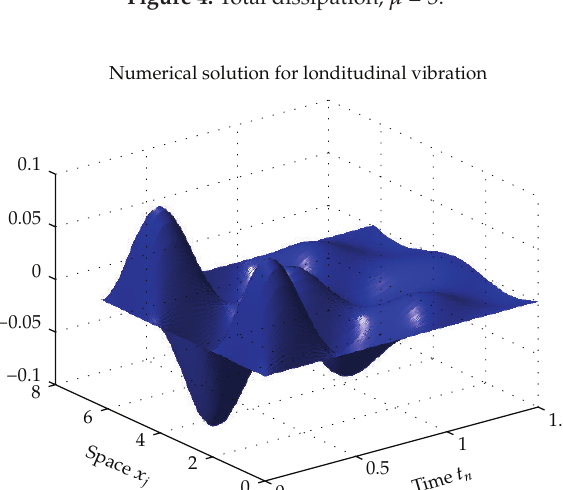
Figure 4: Total dissipation, μ (cid:8) 3.